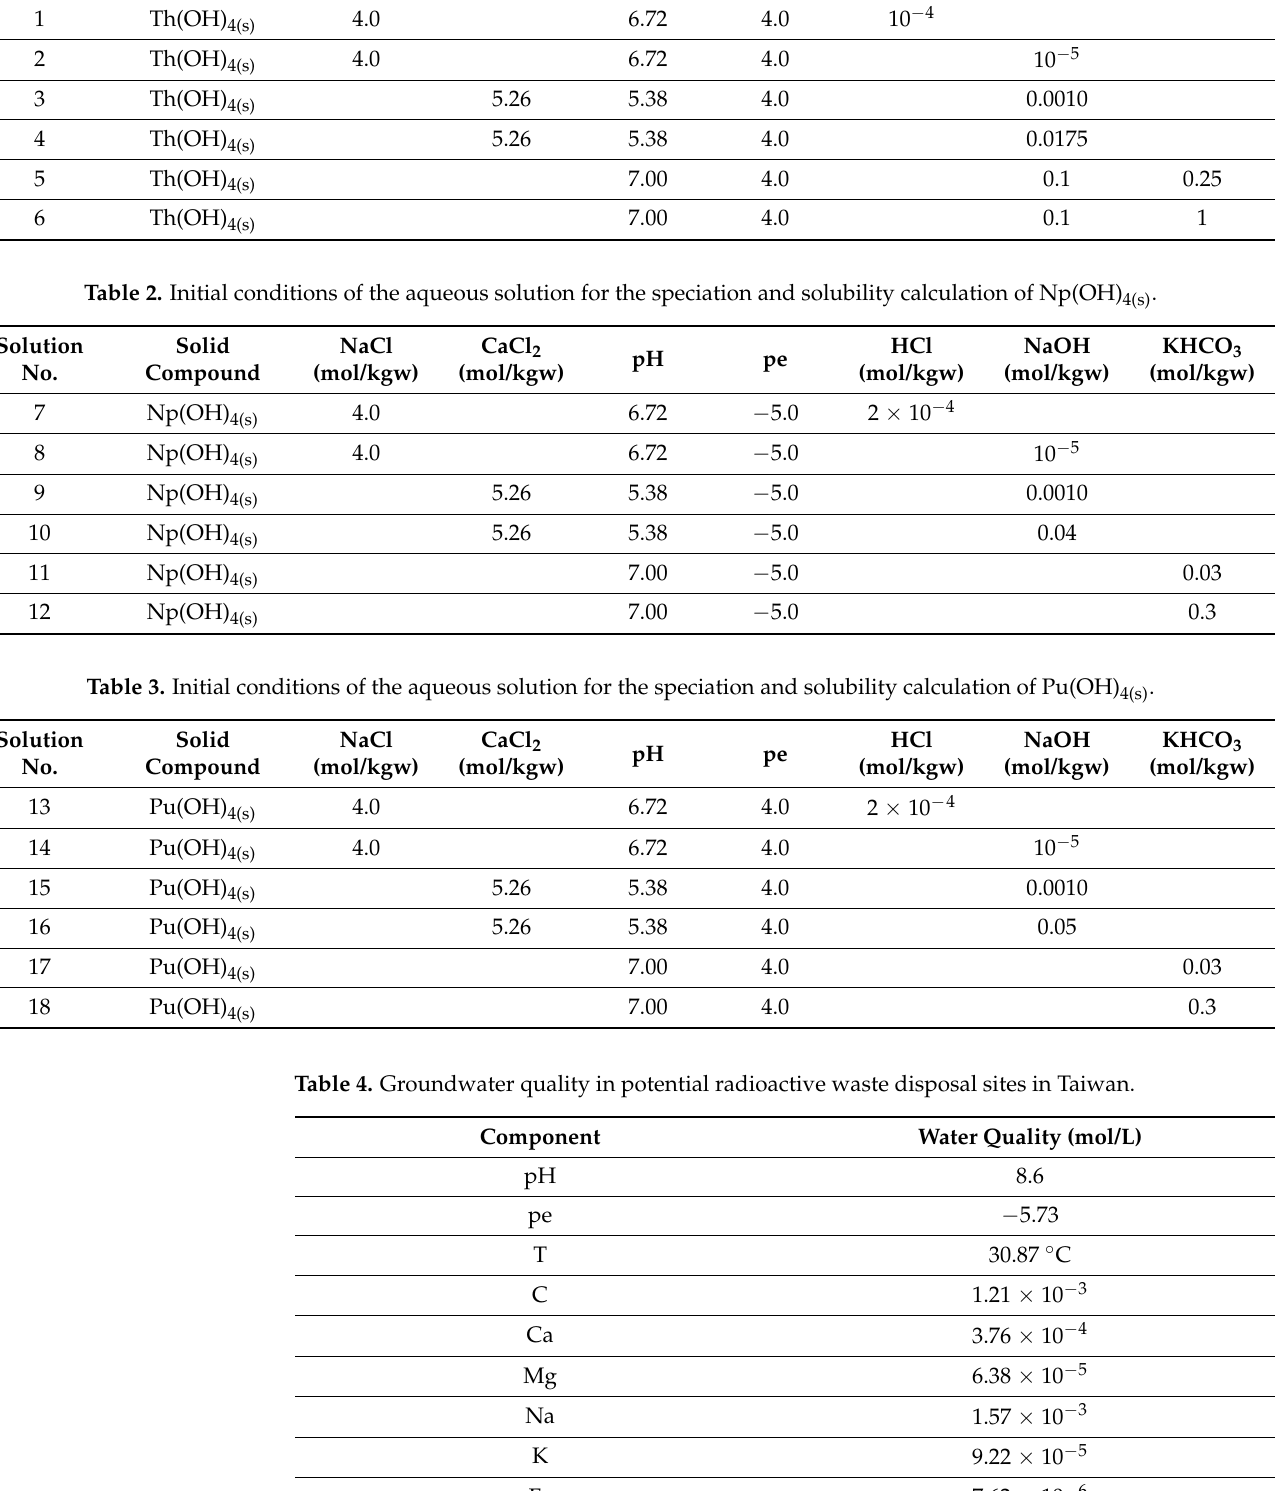
Table 1. Initial conditions of the aqueous solution for the speciation and solubility calculation of Th(OH) 4(s) . Solution No.